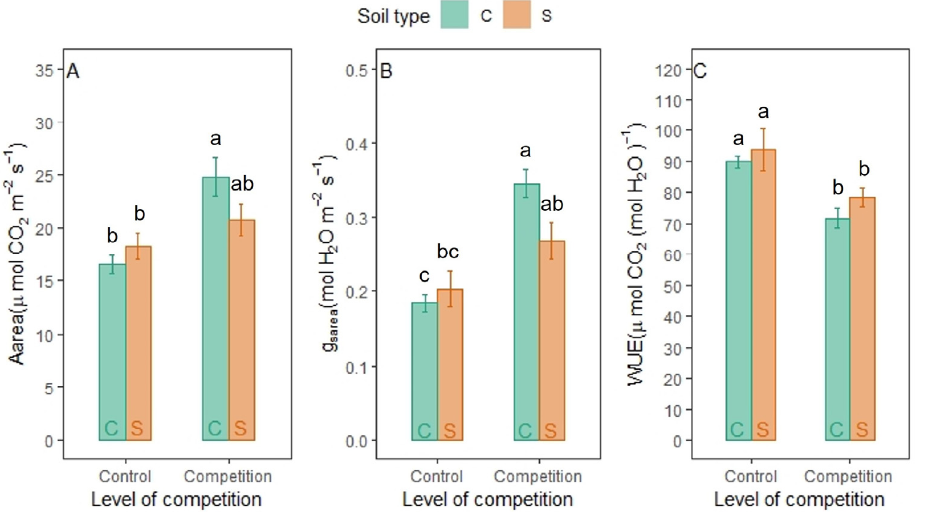
Figure 4. Effect of soil type and competition on net photosynthesis per area (A area ) ( A ), stomatal conductance per area (g Sarea ) ( B ), and water use efficiency (WUE) ( C ) of LANZA ® measured at the end of the experiment. Mean values ( n = 6) not sharing a common letter differ significantly ( p < 0.05) according to Tukey’s test. Error bars show standard errors. C: clay soil; S: loamy sand soil.